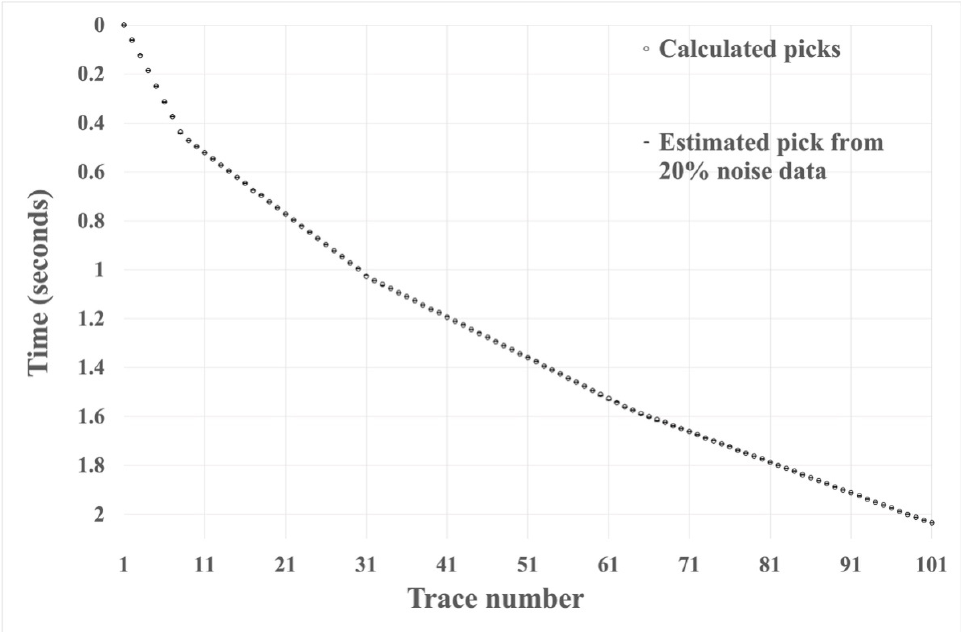
Figure 8. First arrival picks determined by the HEEH method and calculated from the model on synthetic data with 20% noise.